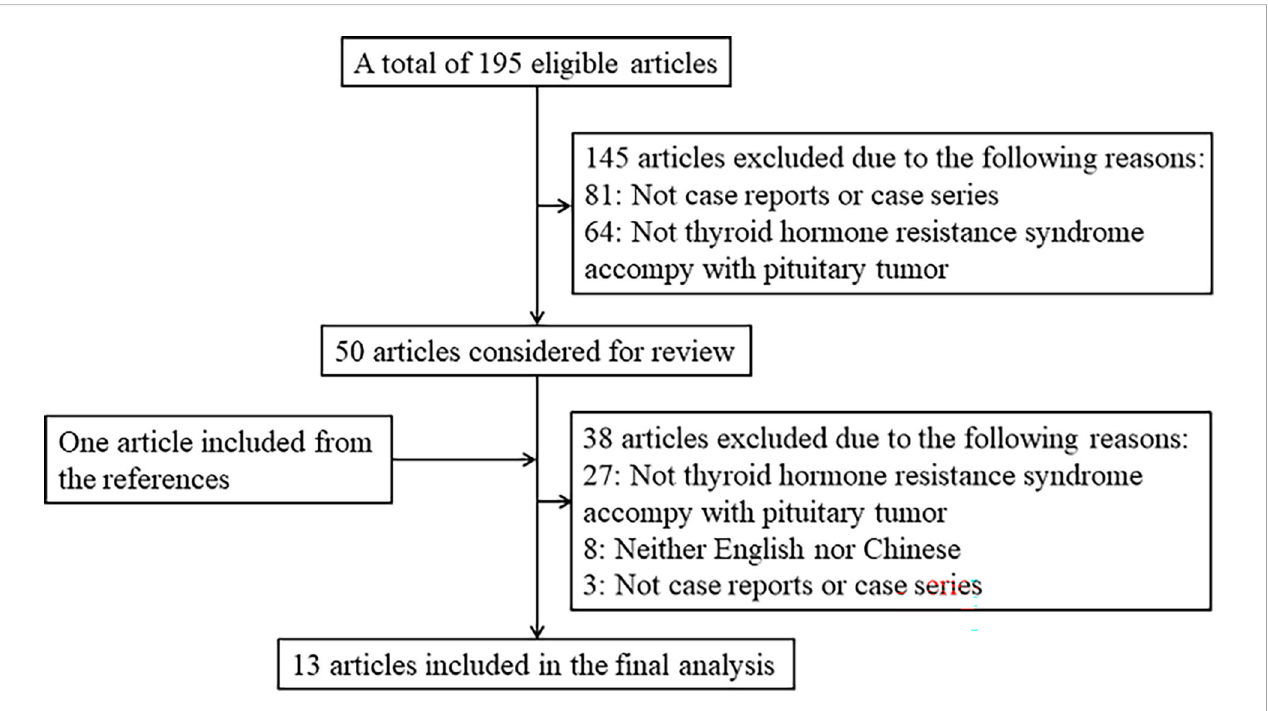
FIGURE 1 Literature review inclusion